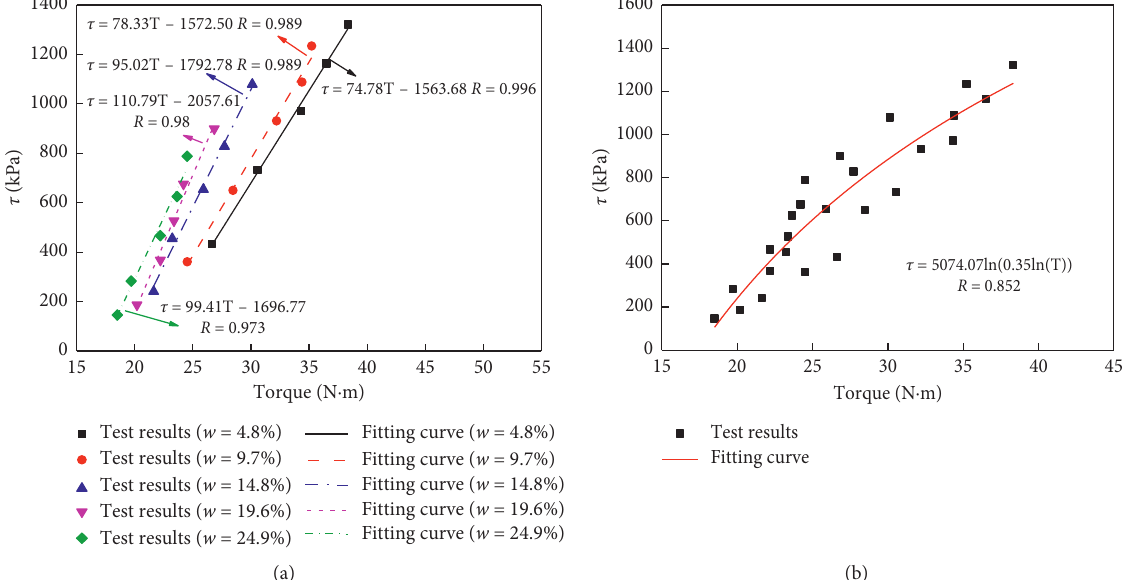
Figure 10: Relationship between torque and shear strength: (a) considering water content and (b) without considering water